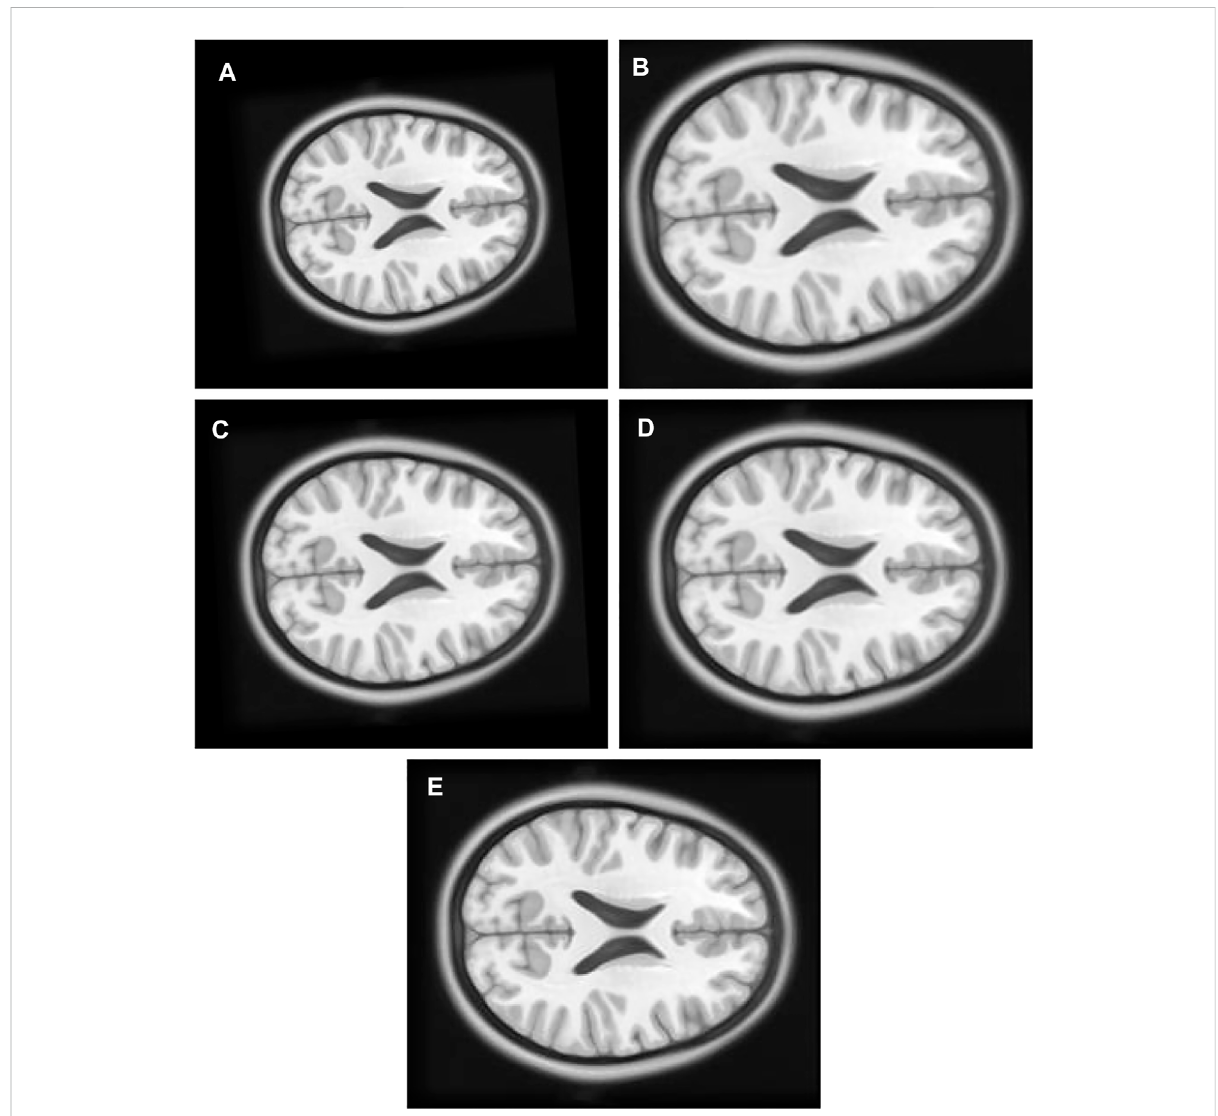
FIGURE 13 (A) Single Modal Experiment 2 Float: row fi rst left. (B) Single Modal Experiment 2 GA output: row fi rst right. (C) Single Modal Experiment 2 PSO output: row second left. (D) Single Modal Experiment 2 PSO and Powell Output: row second right. (E) Single Modal Experiment 2 TPSysIR Output: row third